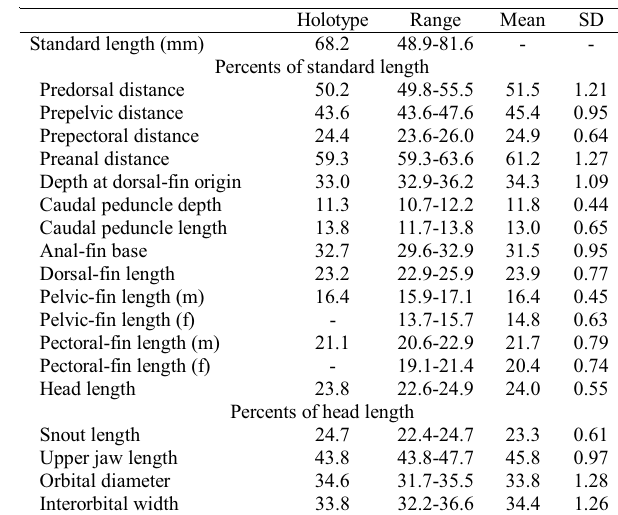
Table 1. Morphometric data of holotype (MCP 28860, male) and paratypes (6 of MCP 41346, 5 of MCP 41347, 4 of MUSM 28039, and 3 of MUSM 28040) of Hemibrycon divisorensis from the río Ucayali drainage, Loreto, Peru. The range in- cludes the holotype. m, males (n = 6); f, females (n = 13). SD